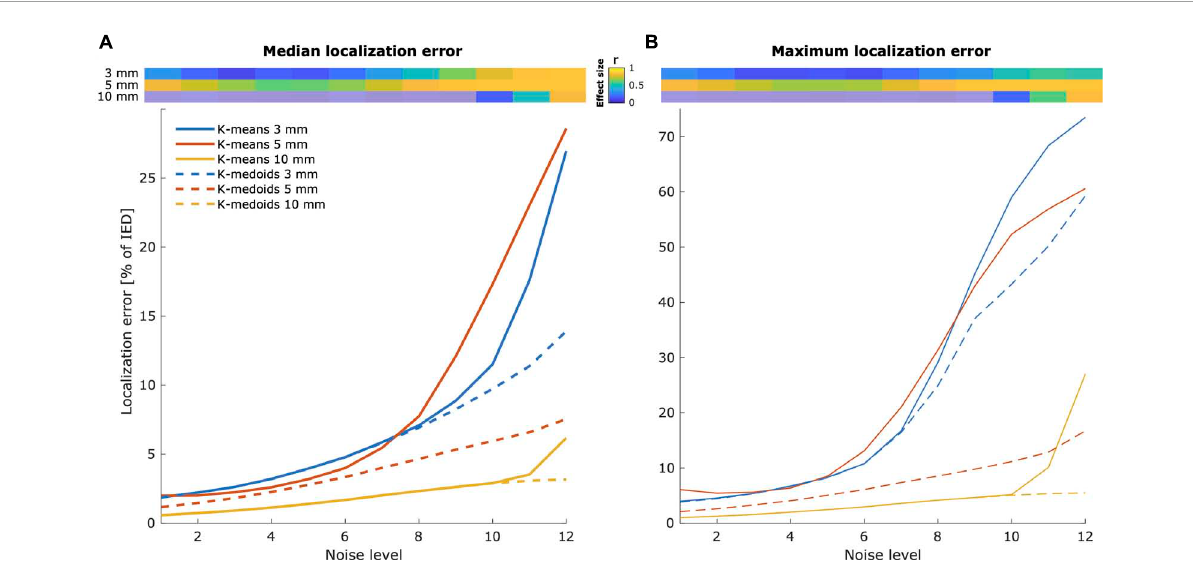
FIGURE9 Localization error is affected by the noise level. Localization errors from k -means and k -medoids clustering algorithms. Localized coordinates were contrasted with the ground truth simulated coordinates to obtain localization errors. The median (A) and the maximum (B) localization error increase with the simulated noise level. Grids and strips of 3 and 5 mm IEDs are more likely to be affected by noise than arrays of 10 mm IED. The top images show the effect size of the difference between k -means and k -medoids methods. Non-significant differences are depicted with semitransparent